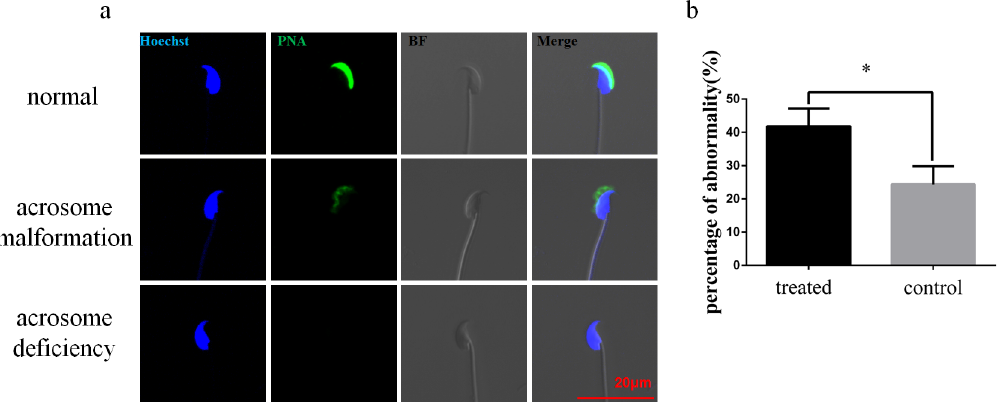
Fig 4. Immunofluorescence detection of the acrosome. (a) Immunofluorescence detection of the acrosome with PNA (green) was performed to illustrate and quantify the sperm acrosome abnormalities. Hoechst was used to nuclei staining (blue); bar = 20 μ m. (b) The rate of abnormalities including acrosome malformation and deficiency was significantly higher in miR-124 mimic group (41.8%), compared with the control group (24.4%, p = 0.021).